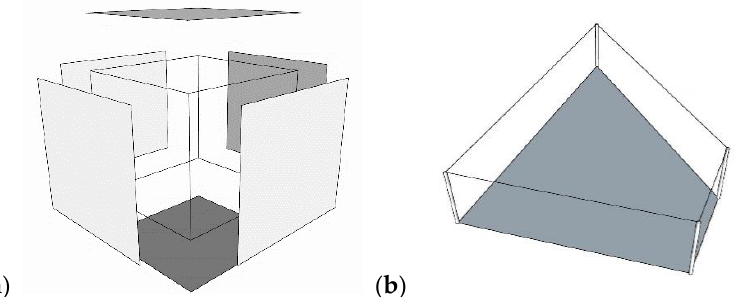
Figure 2. SemanticTransformation with outer setting offsets each bounding surface of a solid to- wards the outer direction ( a ) and Unbounded3DStroke uses linear primitives to illustrate an un- bounded 3D parcel ( b ).